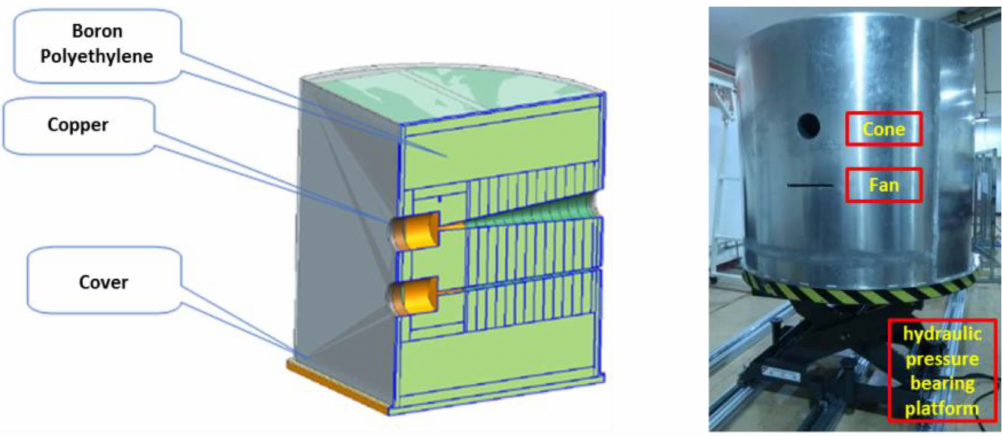
Figure 5. Assembling diagram and picture of the collimator.